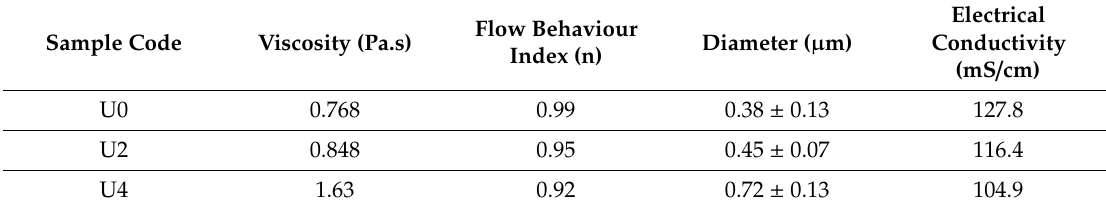
Table 1. Rheological and structural properties of PAN / CTP